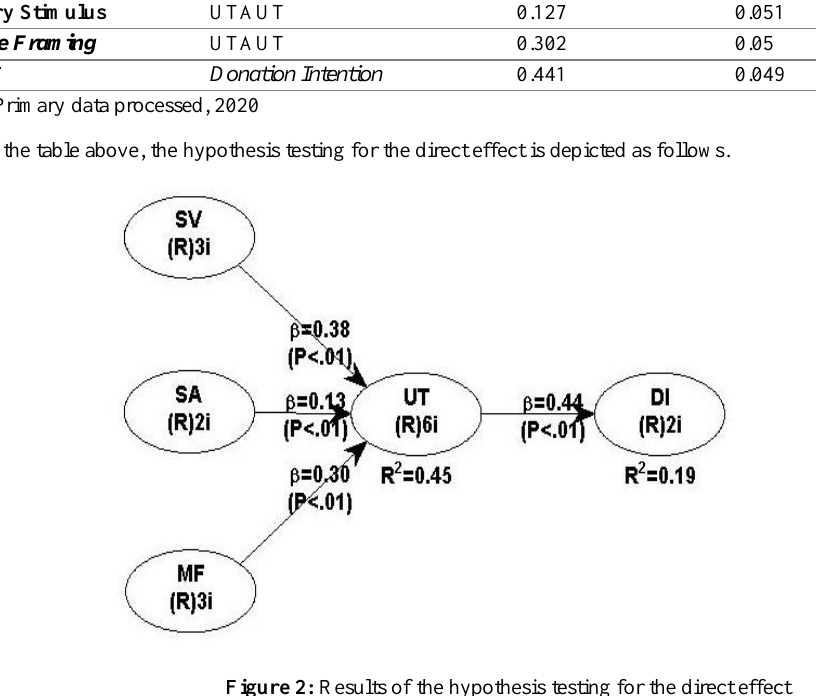
Figure 2: Results of the hypothesis testing for the direct